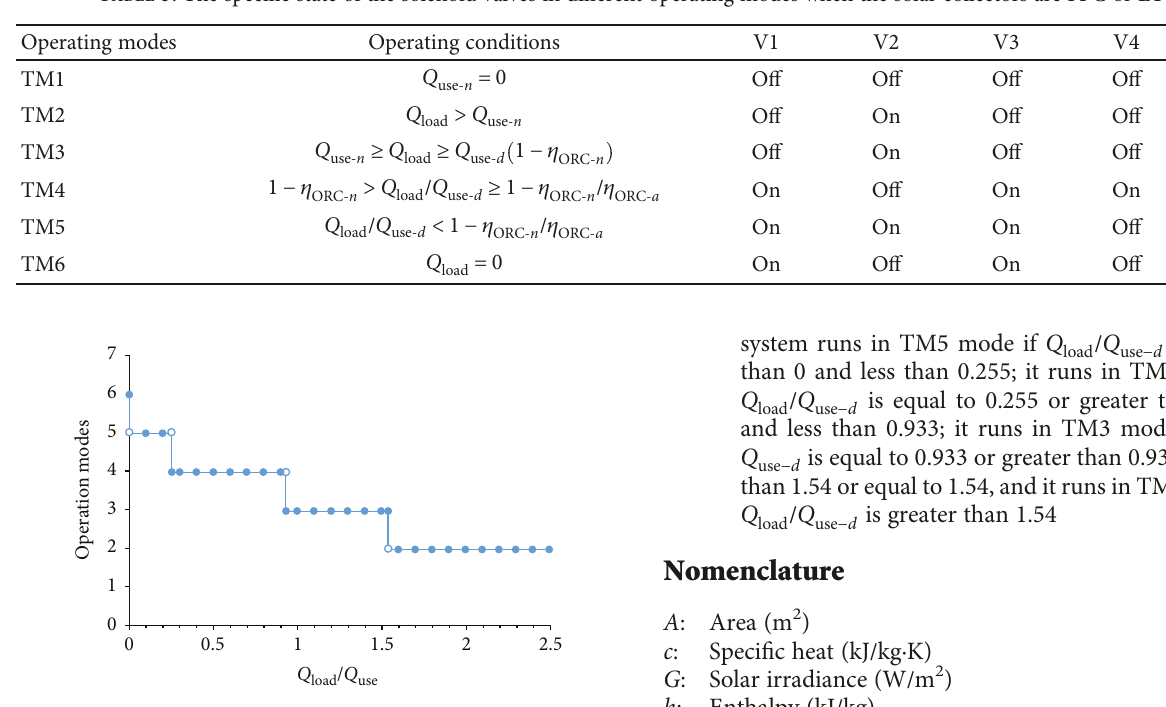
Figure 12: Operation modes of the cogeneration system at di ff erent / Q Q load use − d